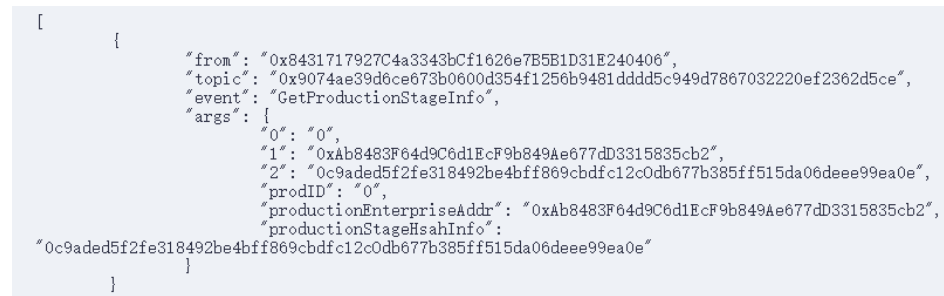
Figure A4. Successful execution of UploadProductionStageInfo Function.